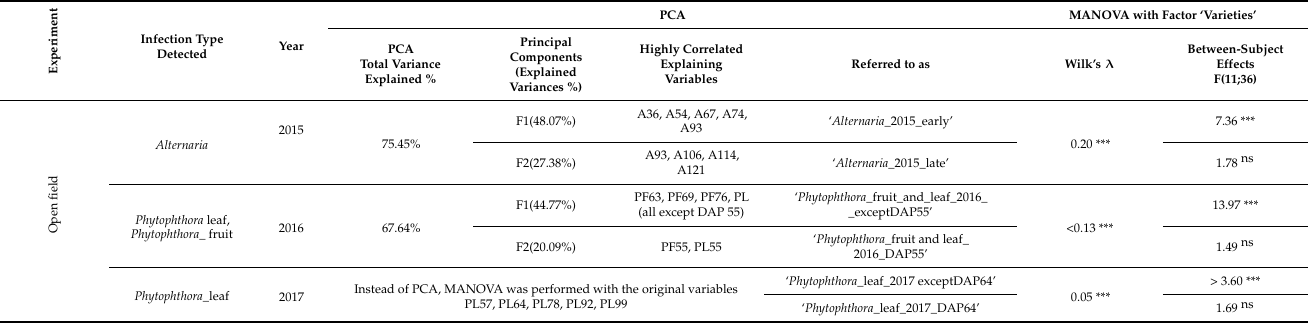
Table 10. The results of the principal component analysis for the infection types of the open-field experiment: the explained variances of the PCs as well as the total explained variance rates; the original variables that are highly correlated with the PCs (with high loadings) and the names that refer to the PCs later on; Wilk’s λ (unexplained variance rate) values (overall MANOVA results) and the follow-up ANOVA tests (between-subject effects) with F values and their significances.